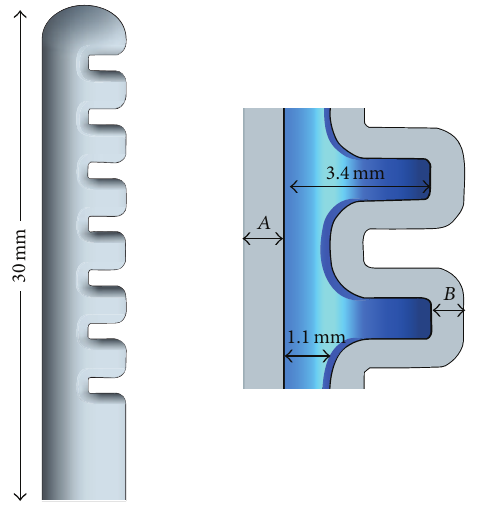
Figure 5: CAD model of the AFPA.